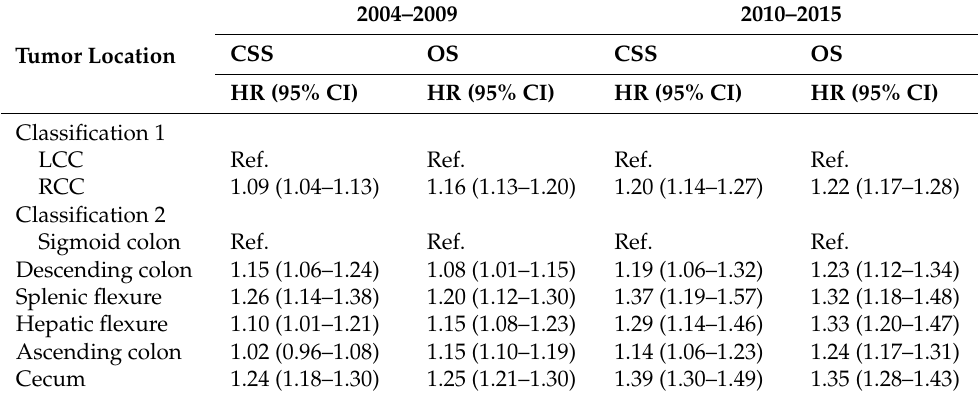
Table 1. Univariate Cox regression analysis of different tumor locations in patients with colon cancer in the SEER